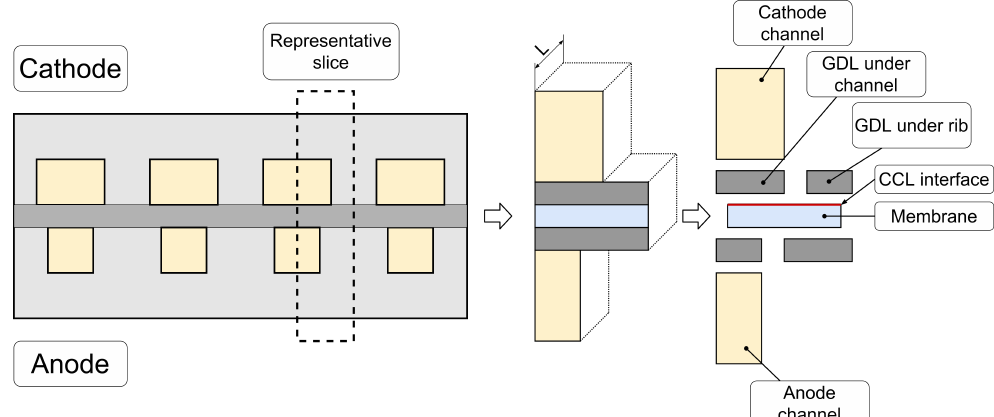
Figure 1. Schematic view of the modeled fuel cell. Co-flow or Counter-flow of Oxygen and Hydrogen is possible. A representative unit of the fuel cell with length L is extracted. Each section of the fuel cell is sliced into cathode and anode channel, GDL parts under-channel, GDL parts under-rib, and thin CCL and membrane. Based on